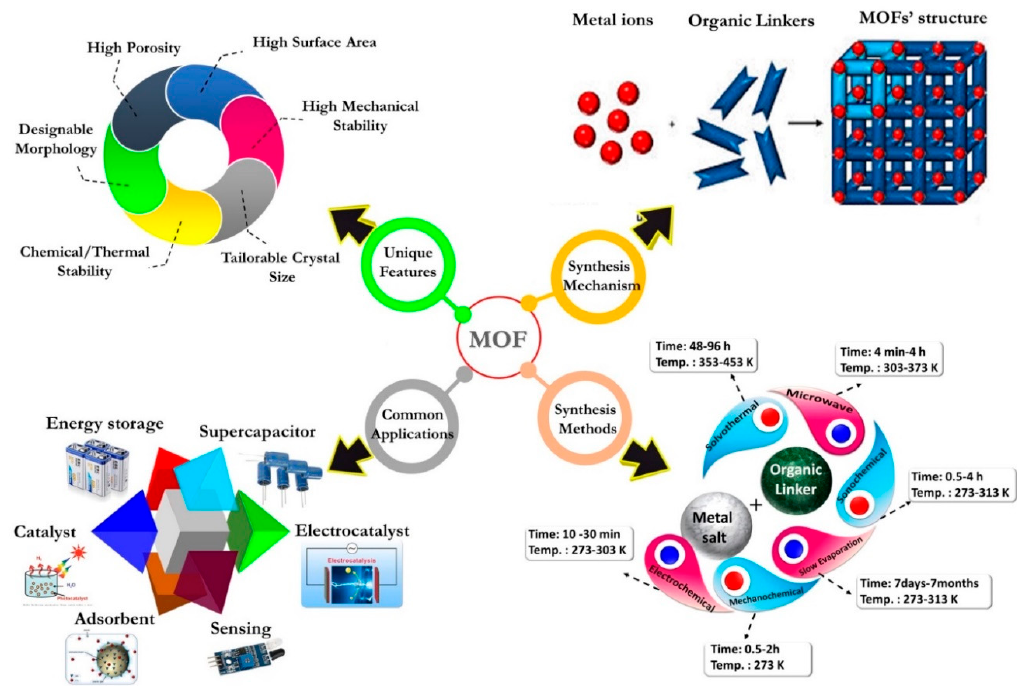
Figure 2. Schematic illustration of the major synthesis routes from solvothermal and microwave to electrochemical techniques with different ranges of temperature and fabrication time applied in MOF synthesis; unique features of MOFs such as chemical/thermal stability, designable morphology, tailorable crystal size, large surface area, and excellent porous structure; typical applications of MOFs such as energy storage, supercapacitors, sensing, and catalysis; and the synthesis mechanism [7,13].